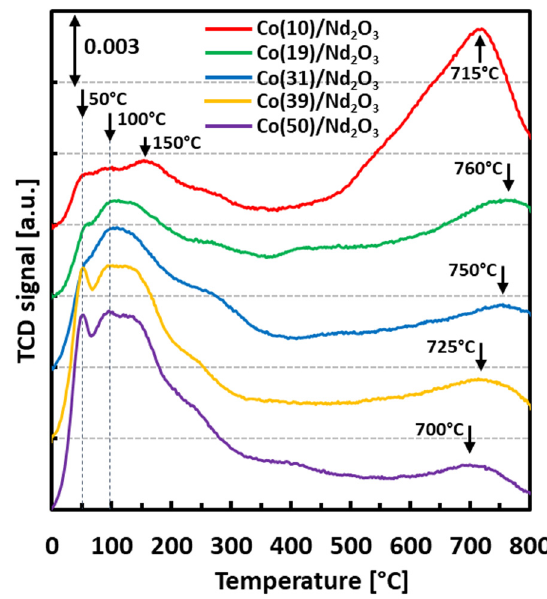
Figure 7. H 2 -TPD profiles for Co/Nd 2 O 3 catalysts.